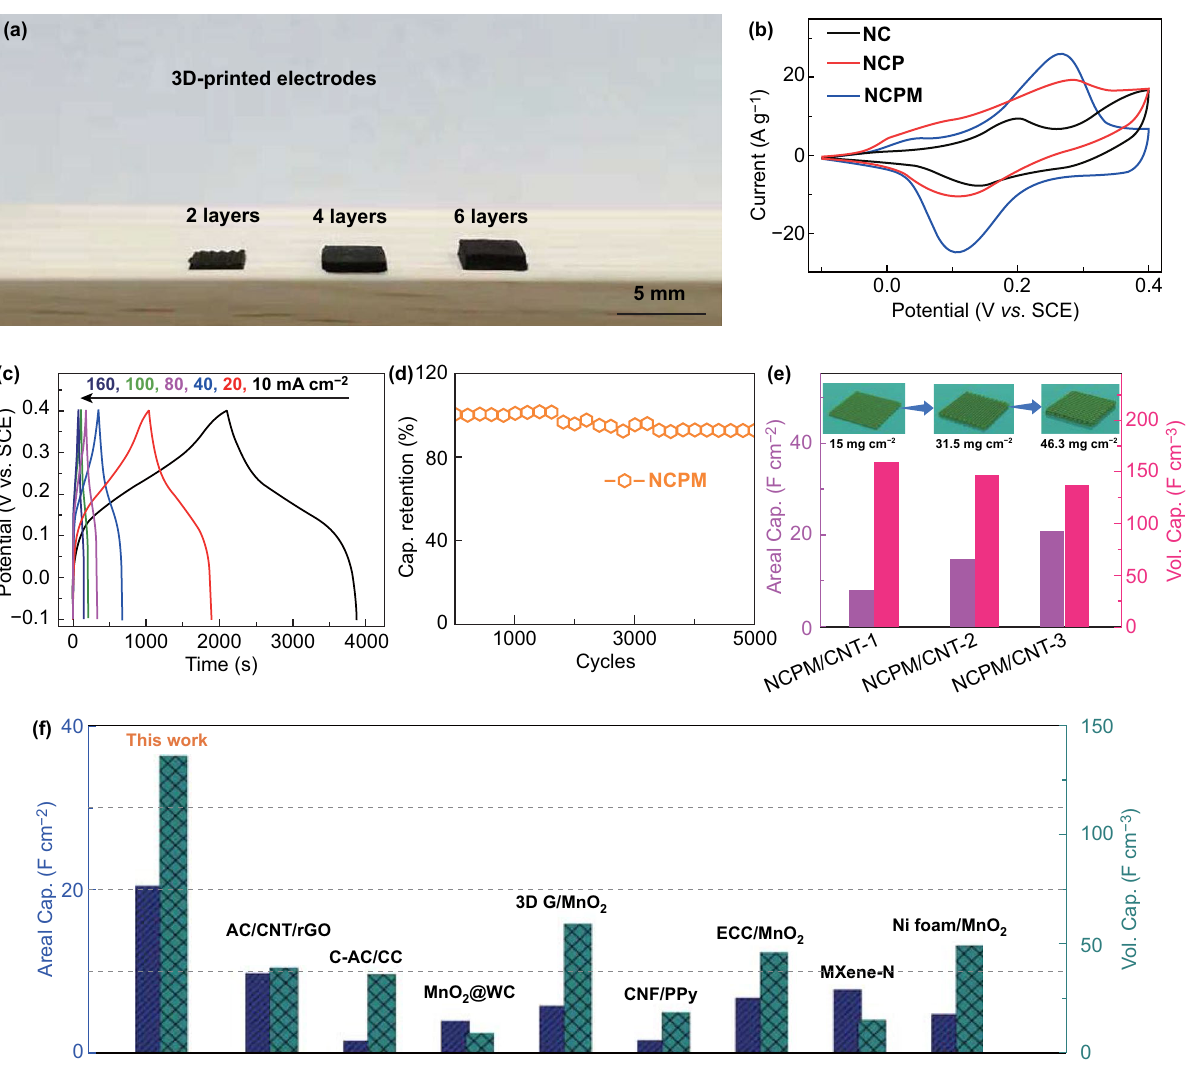
Fig. 4 a Photograph showing the thickness of the 3D-printed NCPM electrodes. b CV profiles of NC, NCP, and NCPM tested in a three- electrode configuration. c GCD curves of printed NCPM/CNT electrode at different current densities. d Cycling performance of printed NCPM/ CNT electrode. e Statistics of areal and volumetric capacitances for the printed NCPM/CNT electrodes possessing different layers. Inset: Sche- matic illustration of NCPM/CNT electrodes with different thicknesses and mass loading. f Comparison of the areal and volumetric capacitances between this work and other reported